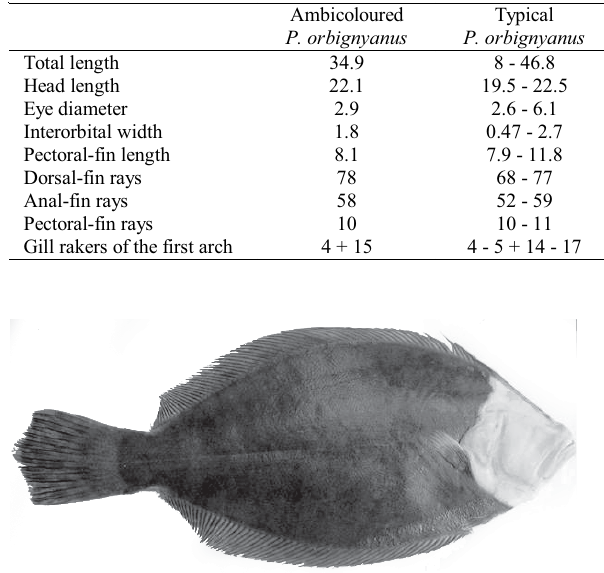
Table 1 . Comparative measurements made upon typical Paralichthysorbignyanus (n = 19) and one ambicolourate speci- men (34.9 cm TL) of the same species. Total length (TL) is expressed in cm. All other measurements as percentages of